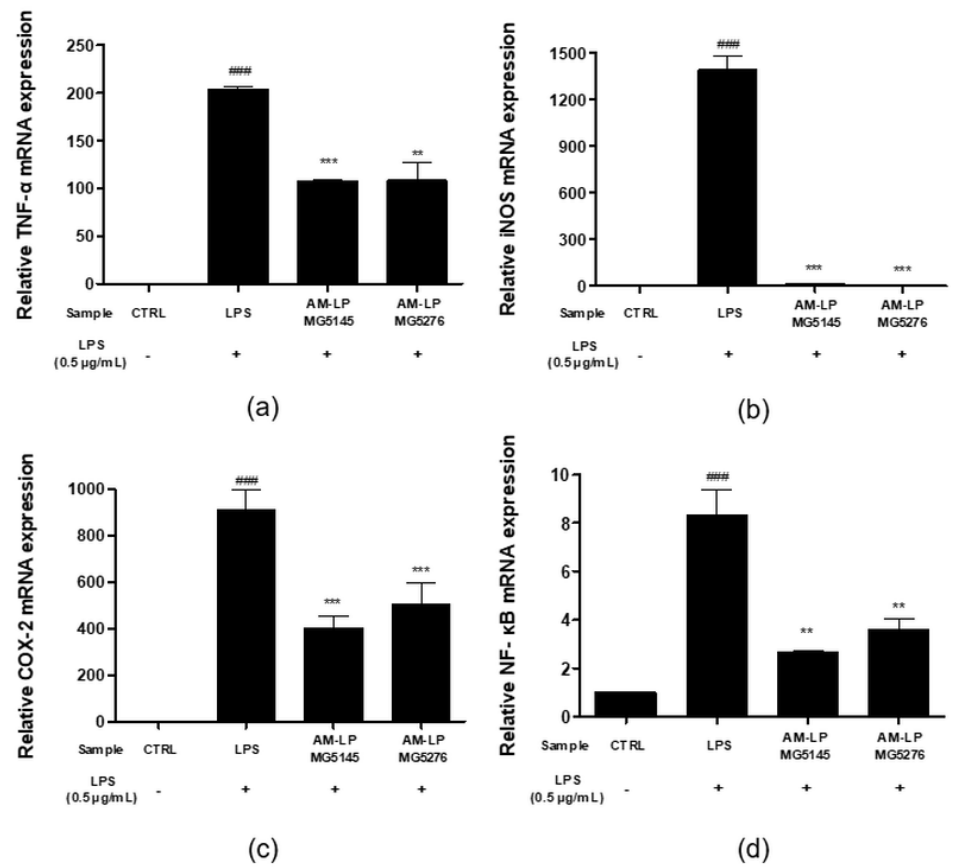
Figure 5. Effect of the AM-LP MG5145 and MG5276 on inflammation-related mRNA production in LPS-induced RAW 264.7 cells. Cells were treated with samples (20% v / v ) and LPS (0.5 μg/mL) for 6 h. The expressions of ( a ) TNF-α, ( b ) iNOS, ( c ) COX-2, and ( d ) NF-κB were measured by qPCR. Data are represented as the mean ± SD ( n = 3). All data were normalized by GAPDH. ### p < 0.001 compared to untreated LPS control. ** p < 0.01 and *** p < 0.001 comparing treated LPS control.